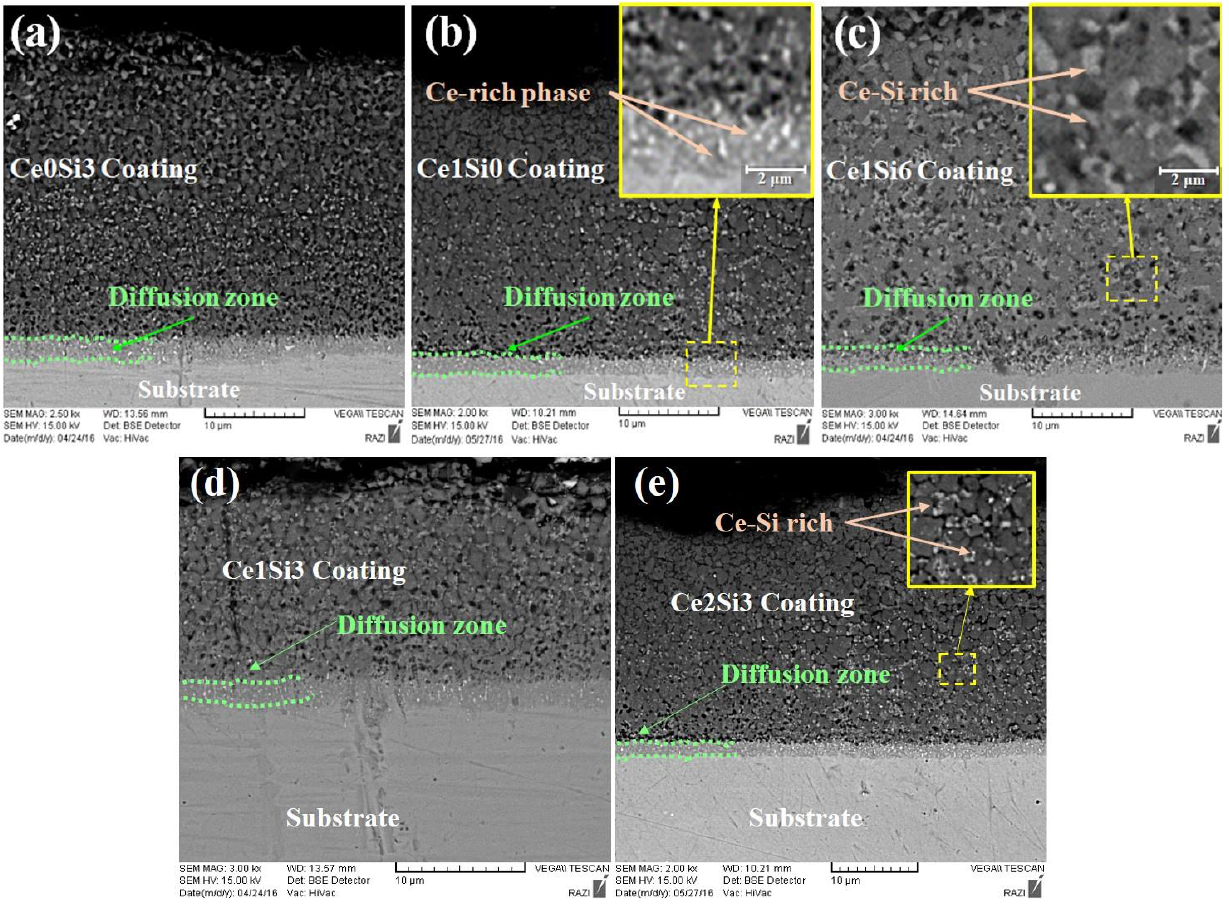
Figure 3. Cross-sectional image micrograph of the modified aluminized coatings consisting of two distinguished layers, ( a ) Ce0Si3, ( b ) Ce1Si0, ( c ) Ce1Si6, ( d ) Ce1Si3, and ( e ) Ce2Si3 coatings. Table 3. Elemental percentage (wt.%) on the selected samples by EDX analysis.